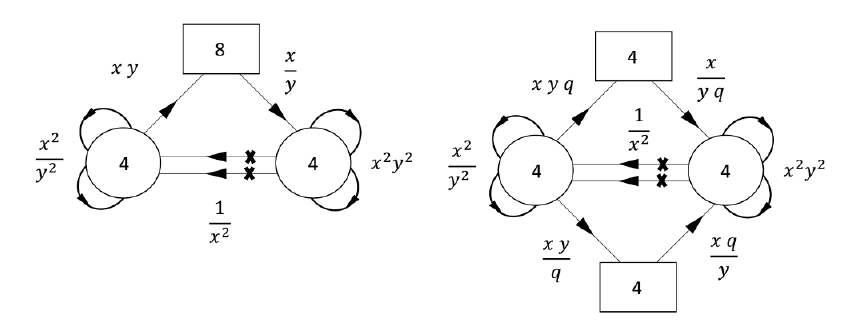
Figure 3. The 4 d theory conjectured to be the result of the compacti(cid:12)cation of the Spin(7) (cid:2) E 7 conformal matter on a torus with (cid:13)ux 1 in the Spin(7) preserving U(1) (cid:2) SU(2) (cid:2) SU(2). Here there is a cubic superpotential along the triangle and a quartic one coupling the two antisymmetrics via the bifundamentals. There are also two singlet chiral (cid:12)elds (cid:13)ipping the baryons made from the bifundamentals. The visible global symmetry here is SU(8) (cid:2) SU(2) (cid:2) U(1) x (cid:2) U(1) y where the SU(2) rotates the two antisymmetrics. From 6 d , it is expected that SU(8) ! E 7 and U(1) y ! SU(2). There is also a U(1) R R-symmetry under which the bifundamentals have R-charge 0, the (cid:13)ippers have R-charge 2, and the rest have R-charge 1.